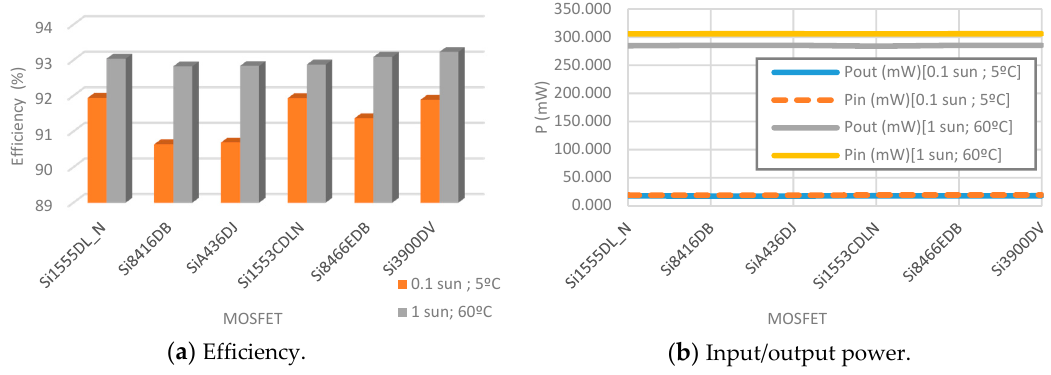
Figure 10. Comparisons between MOSFETs at 0.1 sun and 5 °C; and 1 sun and 60 °C.